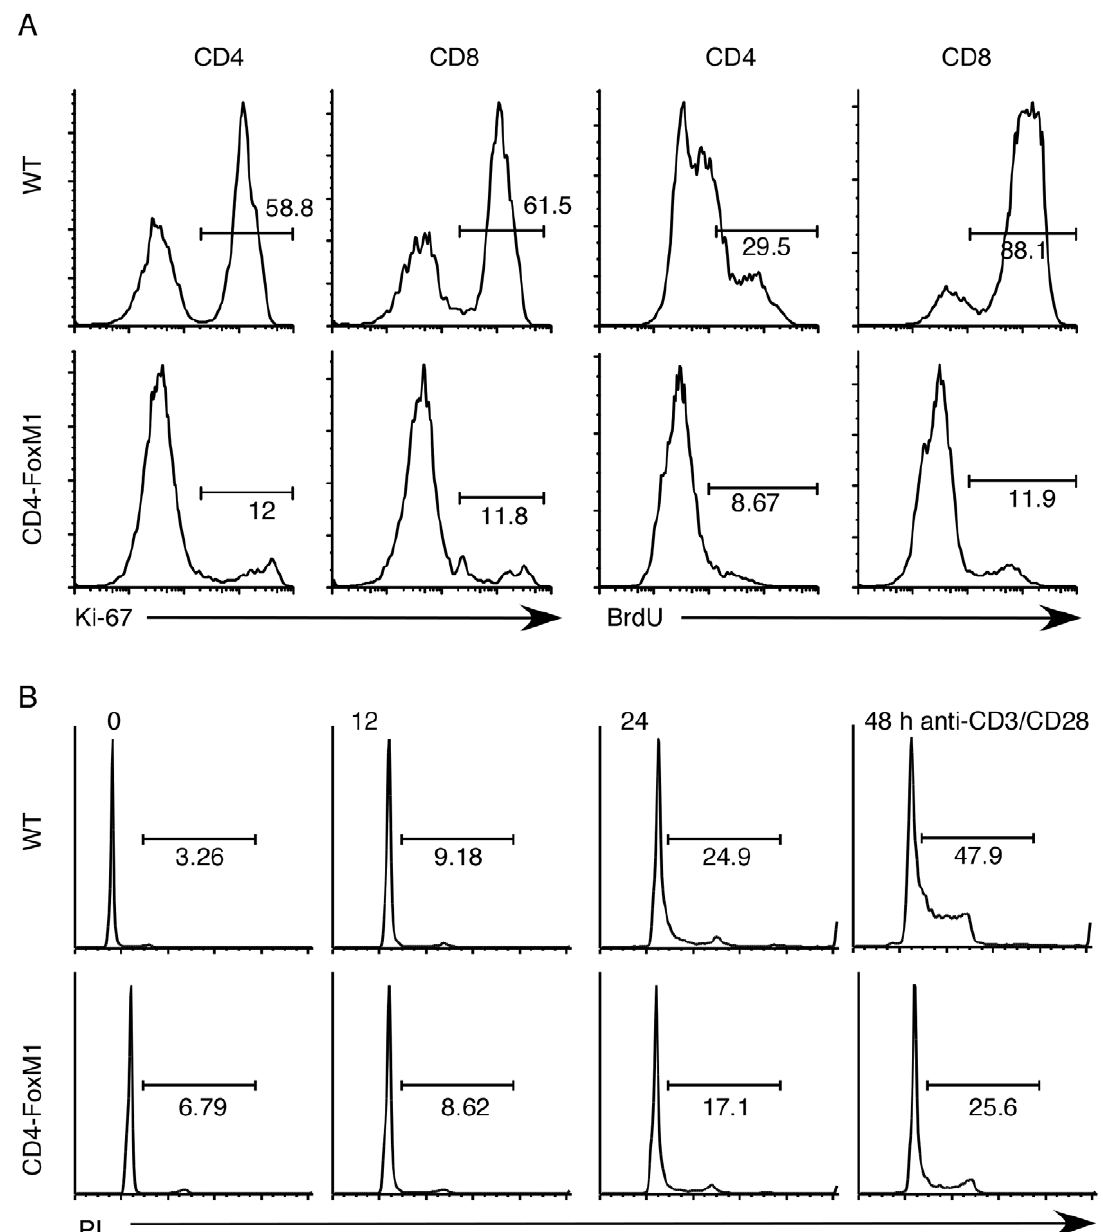
Figure 3. Reduced expression of FoxM1 affects proliferation of peripheral T cells. For both (A) and (B), purified peripheral T cells from CD4- FoxM1 mice or their wild-type littermate controls were stimulated with plate-bound anti-CD3/CD28 antibodies for 48 hr. (A) Left panel: non-G 0 cells were measured by Ki-67 staining. The percentages of Ki67 + cells are as shown as the numbers in the figure. Right panel: Proliferation was measured using BrdU incorporation. The percentages of BrdU + cells are as shown numbers in the figure. (B) Propidium iodide (PI) staining. The percentages of cells in both S and G 2 phases were shown in the figure. The cell cycle analysis was done for the samples stimulated for 48 hr: wild-type (G 1 =34.9%, S=57.8%, and G 2 /M=5.9%) and CD4-FoxM1 (G 1 =56.3%, S=33%, and G 2 /M=5.82%). These experiments were repeated several times with similar